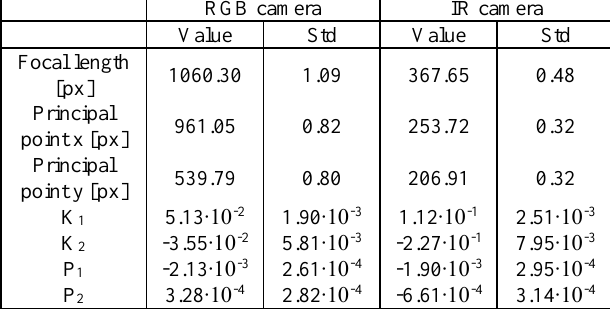
Table 1. Estimated IO parameters of the imaging sensors